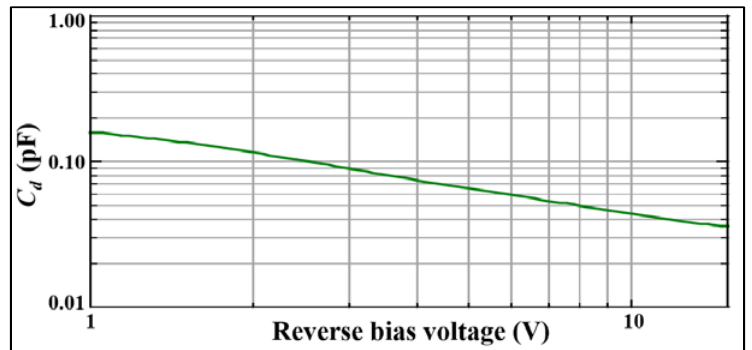
Figure 6. Varactor capacitance values C d as a function of the reverse bias voltage in log scale.